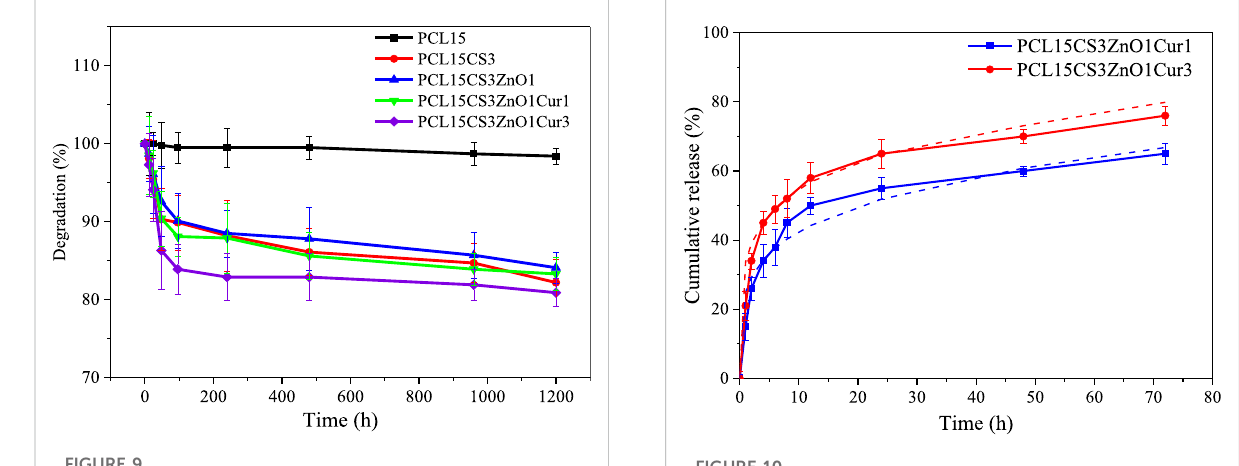
FIGURE 9 Degradation behavior of the electrospun samples.